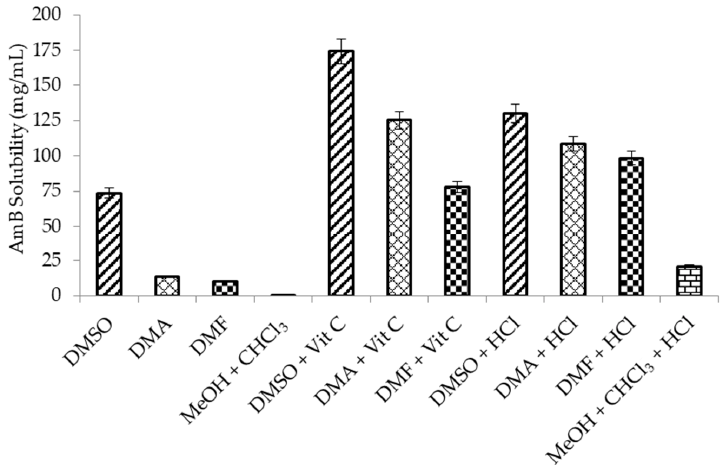
Figure 2. The solubility of amphotericin B (AmB) in different organic solvents at 65 °C. dimethyl sulfoxide (DMSO), N , N -dimethylacetamide (DMA), N , N -dimethylformamide (DMF), and an equivolume solution of MeOH + CHCl 3